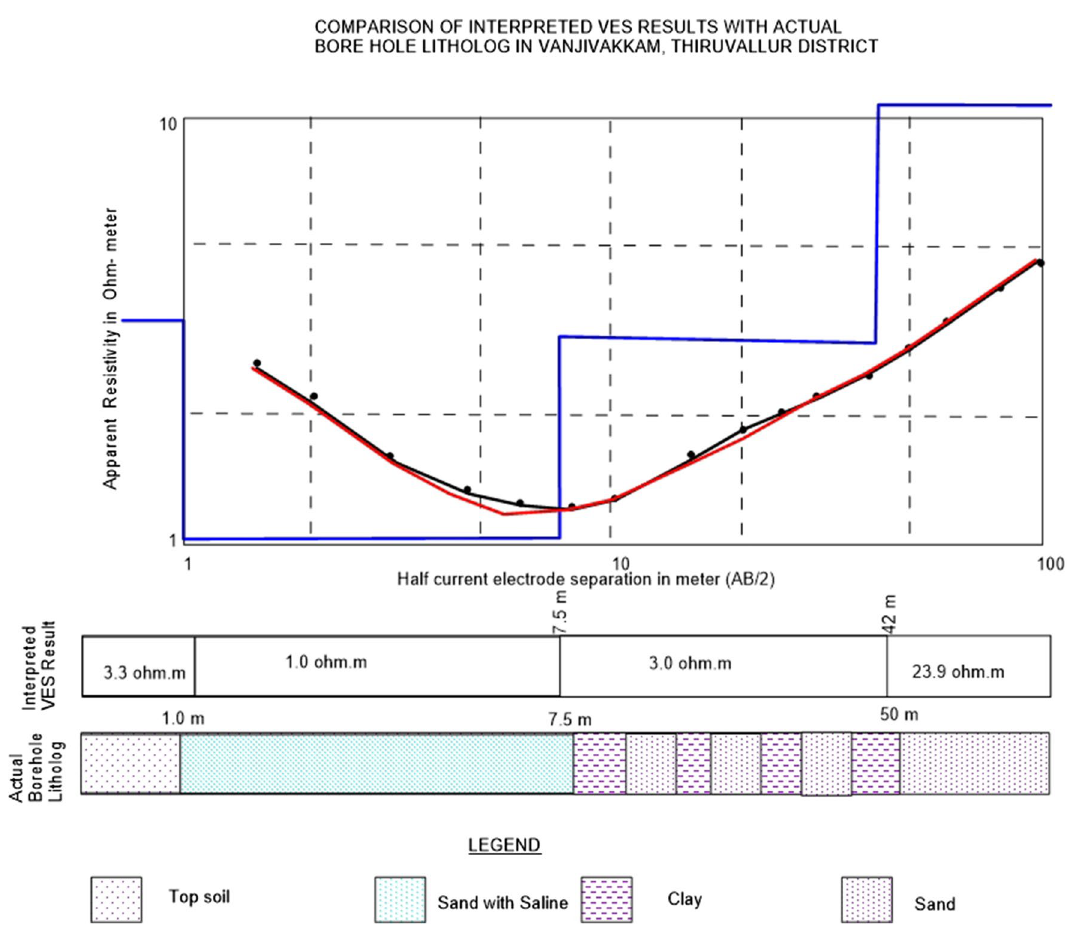
Fig. 9 VES results and borehole lithology calibration in the study area (VES location No.7)